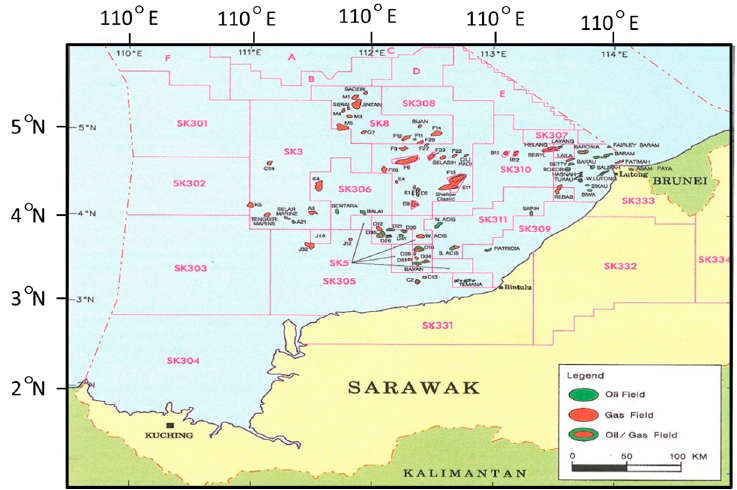
Figure 3. Location map of the study area [10]. The data used in this research is of the Sarawak Basin which is the Lucania Carbonate field.